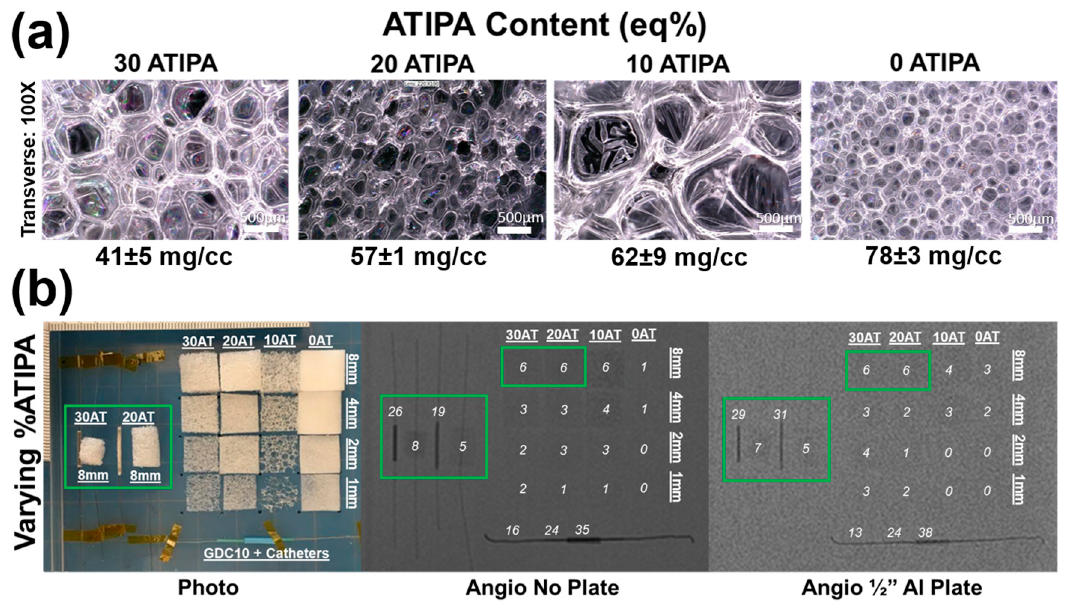
Figure 4. ( a ) Light microscopy images of foams with varying ATIPA content at 100× magnification. Images are labeled with average ± standard deviation of density measurements ( n = 6); ( b ) X-ray images of foams with varying ATIPA content at varying thicknesses. 8 mm diameter peripheral embolization prototypes are boxed in green. Commercial platinum embolic coil, microcatheter, and guide catheter segments are included for comparison. Each sample is labeled with the average 8-bit decimal grayscale shift relative to the image background.